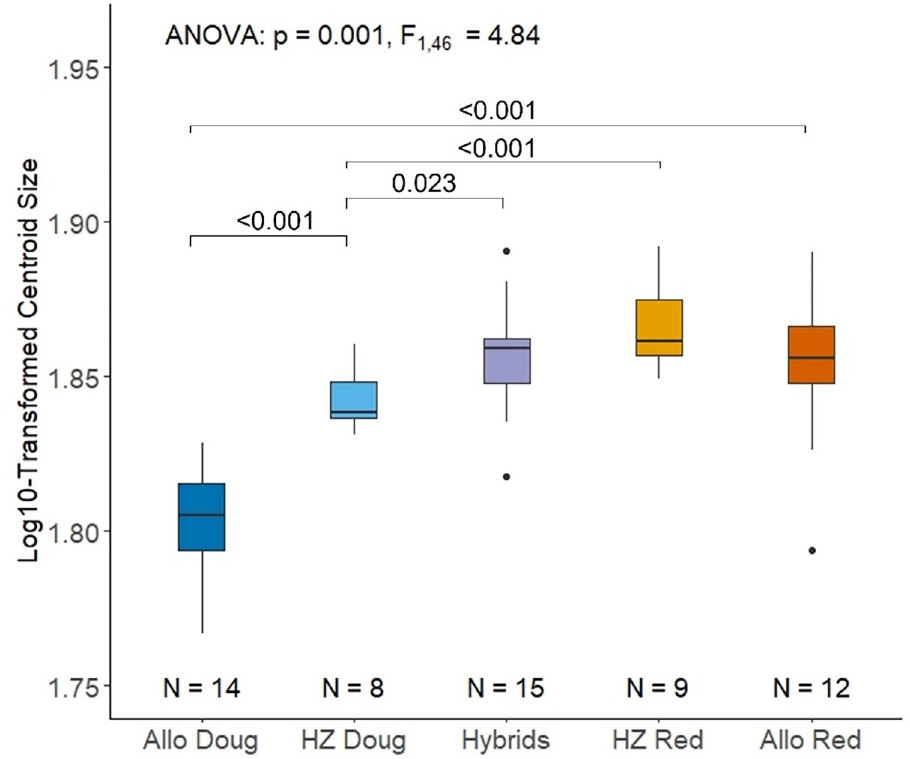
Fig 5. Variation in log10-transformed mandible centroid size across squirrel groups. Values on comparison bars represent significant p-values from pairwise comparisons. Outliers are indicated by black dots. Abbreviations are provided in Fig